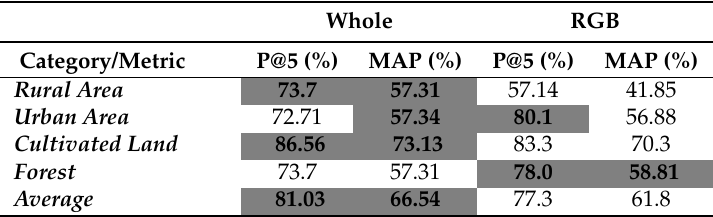
Table 4. Retrieval results for the ANKARA dataset (Land-Use categories).